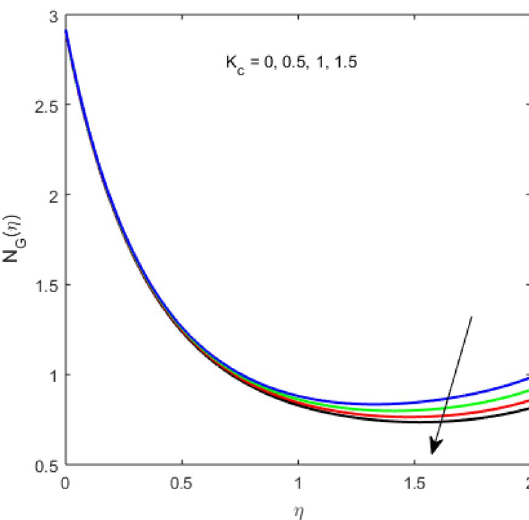
Figure 15. Entropy generation variation for increasing K c